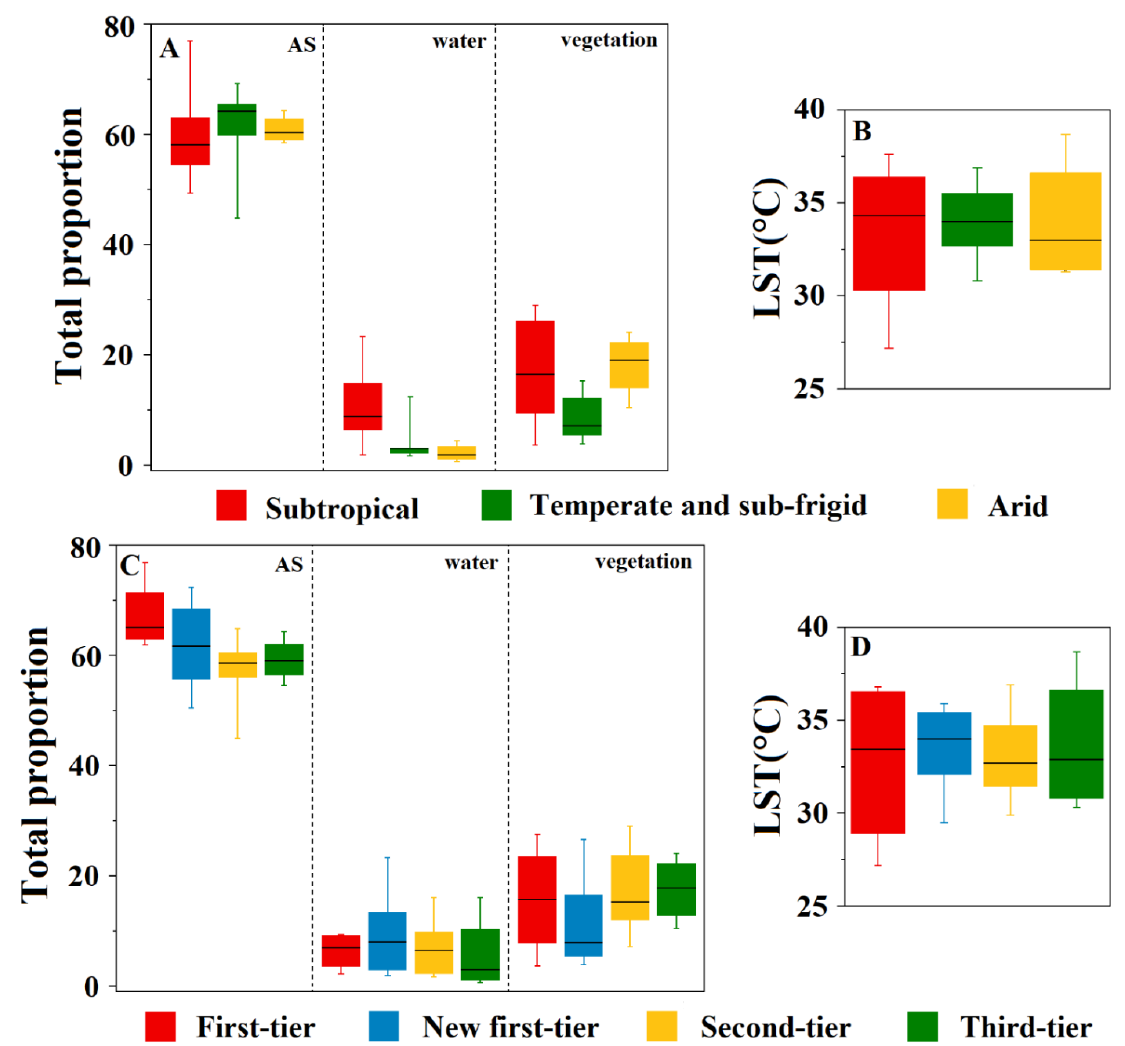
Figure 4. Boxplots of the overall proportions of AS, water, and vegetation, as well as the LST of 28 major urban areas in three climatic zones ( A , B ) and four stages of development ( C , D ). The horizontal lines (boxes and whiskers) from high to low of each boxplot represent the maximum, the first quartile, the median, the third quartile, and the minimum value, respectively.